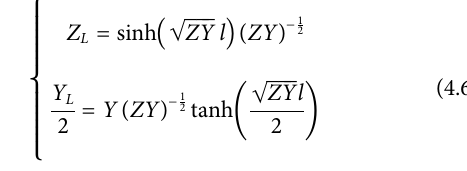
Frontiers in Energy Research |